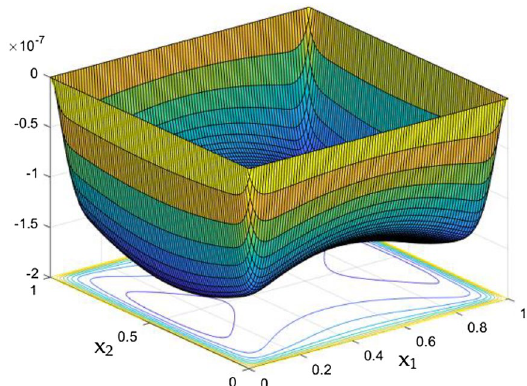
Figure 22. Temperature field for Ra = 100,000 and M = 40.